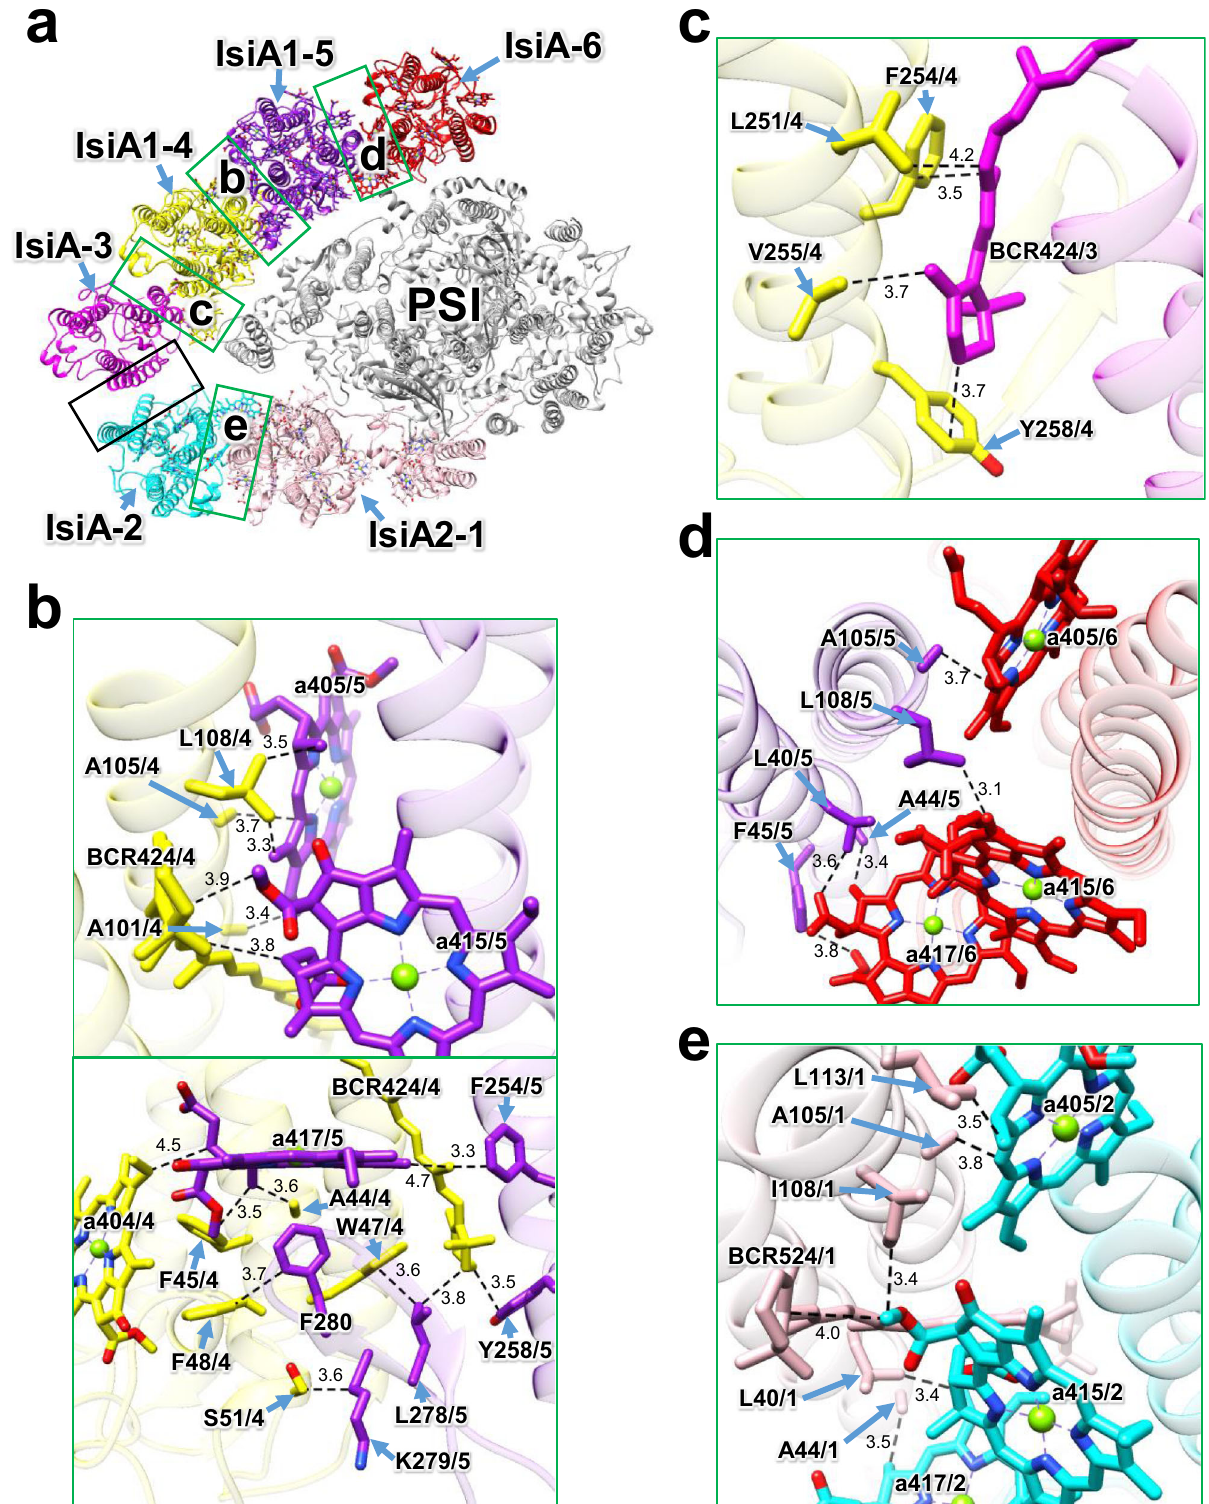
Fig. 5 | Interactions among the IsiA subunits. a Overall structure of PSI-IsiA viewed from the cytosolic side. The green squared areas are enlarged in panels b – e , whereas the black squared area does not have a characteristic interaction in the present structure. b Interactions between IsiA1-4 and IsiA1-5 (upper and lower panels). c , Interactions between IsiA-3 and IsiA1-4. d Interactions